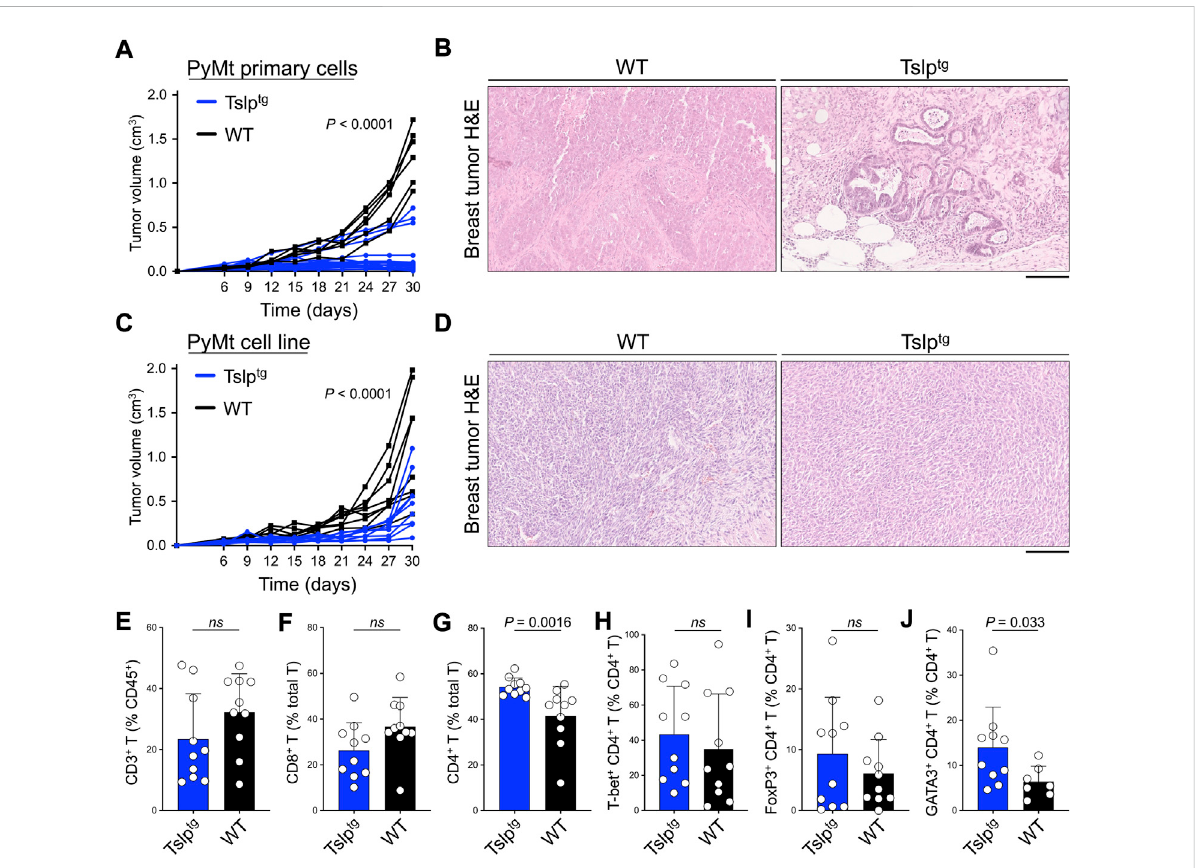
FIGURE 1 TSLP induction protects against early and advanced breast cancer. (A) PyMt tg primary breast tumor growth in Tslp tg (test, n = 19) versus WT (control, n =6)mice( p < 0.0001,two-wayANOVA). (B) Representativeimagesofhematoxylinandeosin(H&E)-stainedPyMtprimarybreasttumorsin Tslp tg versusWTmice. (C) PyMtcellline-derivedtumorgrowthinTslp tg (test, n =9)versusWT(control, n =8)mice( p < 0.0001,two-wayANOVA). (D) RepresentativeimagesofH&E-stainedPyMtcellline-derivedtumorsinTslp tg orWTmice. (E – J) Percent (E) CD3 + TcellsamongCD45 + cells, (F) CD8 + TcellsamongCD3 + Tcells, (G) CD4 + TcellsamongCD3 + Tcells, (H) T-bet + Th1cellsamongCD4 + Tcells, (I) FoxP3 + TregsamongCD4 + Tcells, and (J) GATA3 + Th2cells among CD4 + Tcells, collected from tumors and tumor-draininglymphnodesof Tslp tg (test, n = 10)versusWT (control, n = 10) mice. ns : not signi fi cant, Mann-Whitney U test. Scale bars: 100 μ m, bar graphs show mean +